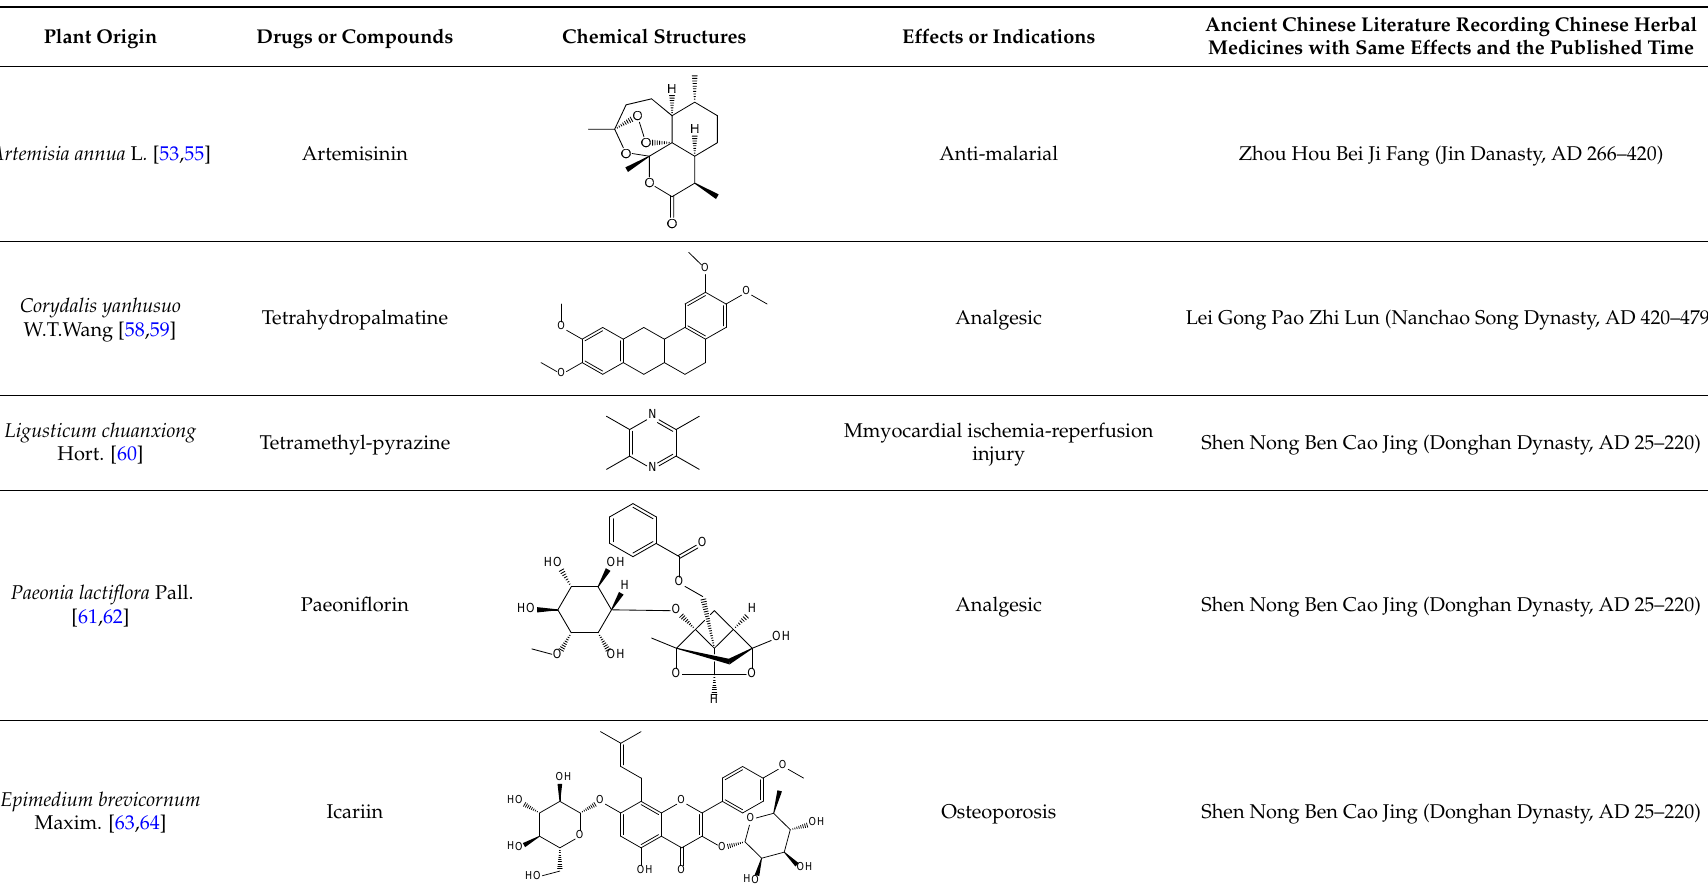
Table 2. Some drugs or compounds isolated from Chinese herbal medicines which follow the traditional uses.